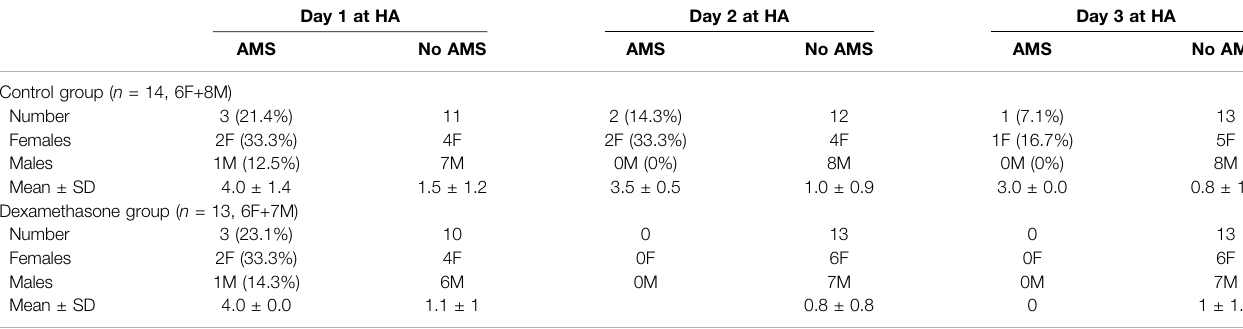
TABLE 1 | Lake Louise Score in the control and dexamethasone groups at HA. Day 1 at HA